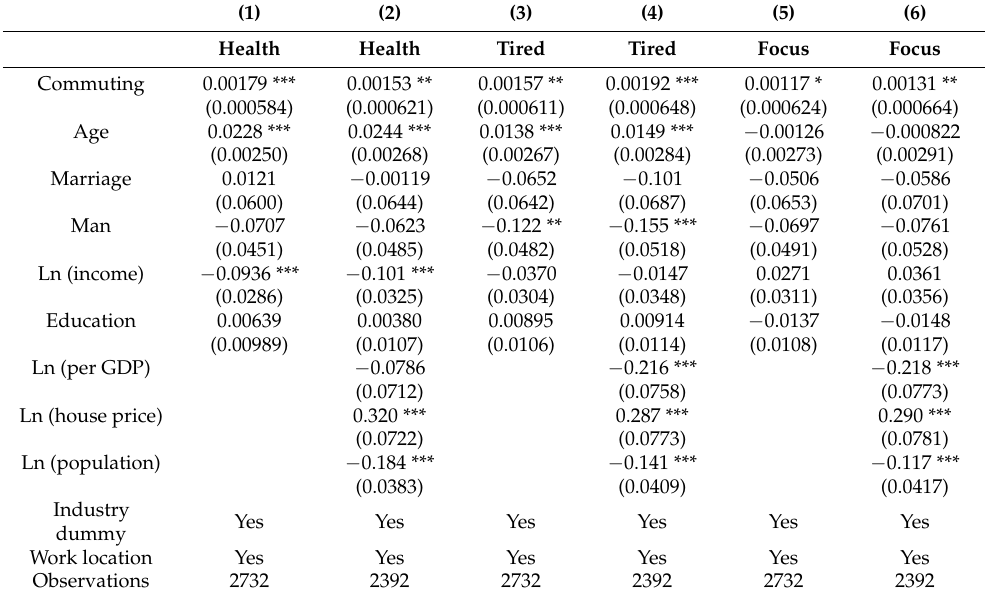
Table 3. Commuting time and quality of